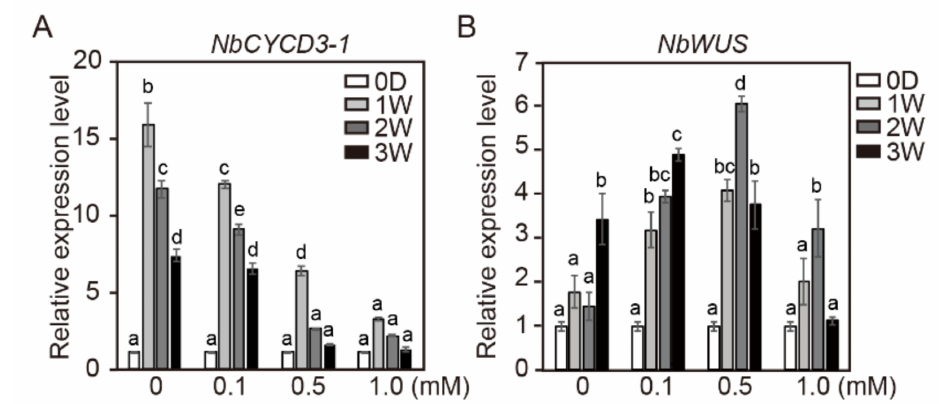
Figure 4. The relative expression levels of NbCYCD3-1 and NbWUS genes in tobacco calli after NaB treatment. The relative gene expression level of NbCYCD3-1 ( A ) and NbWUS ( B ) in tobacco calli cultured in shoot induction medium containing 0, 0.1, 0.5, and 1.0 mM of NaB. Data are representative of the results from three independent experiments. Error bars represent SD ( n = 3). Di ff erent letters on the bars indicate significant di ff erences between each treatment (ANOVA followed by a Turkey’s test, p < 0.05). D = day; W =